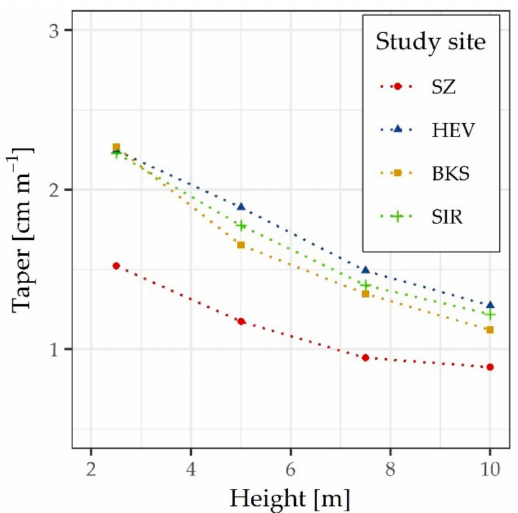
Figure 6. Vertical profile of the taper along the trunk every 2.5 m up to a height of 10 m. SZ = Schattiner Zuschlag (long-term unmanaged), HEV = Hevenbruch (short-term unmanaged), BKS = Berkenstrücken (extensively managed), SIR = Sirksfelder Zuschlag (intensively managed).